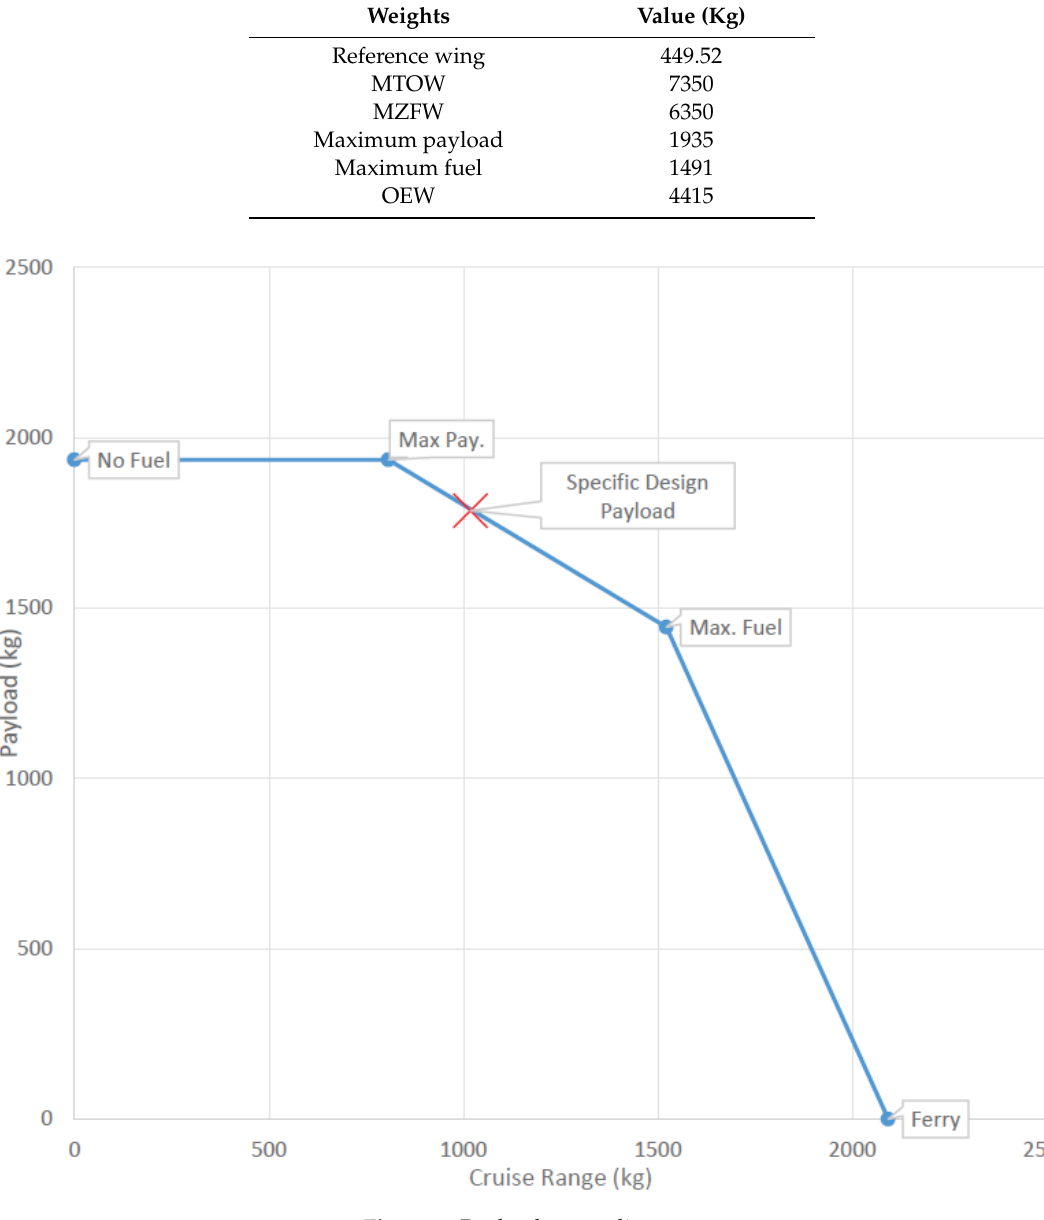
Table 10. Synopsis of the weight data for the Jetstream 31 (cross-checked from [29,42]. MZFW: Maximum Zero-Fuel Weight. OEW: Operating Empty Weight.)